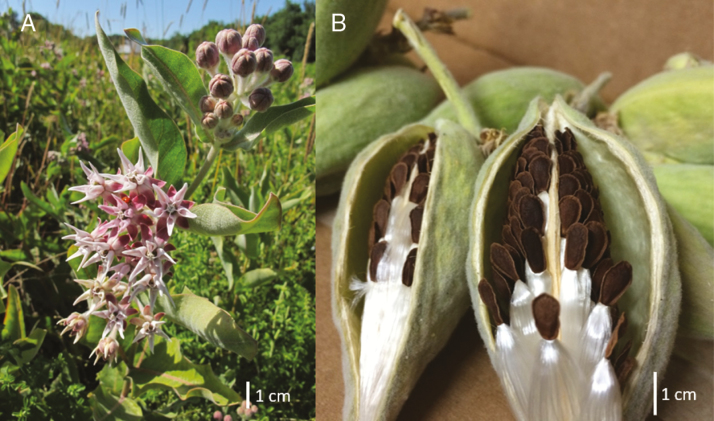

Asclepias speciosa (A) in flower and (B) dehiscing fruit with seeds. Plant photographed in Willamette Valley, OR.